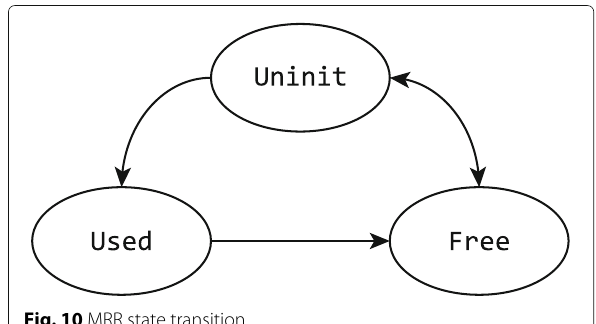
Fig. 10 MRR state transition